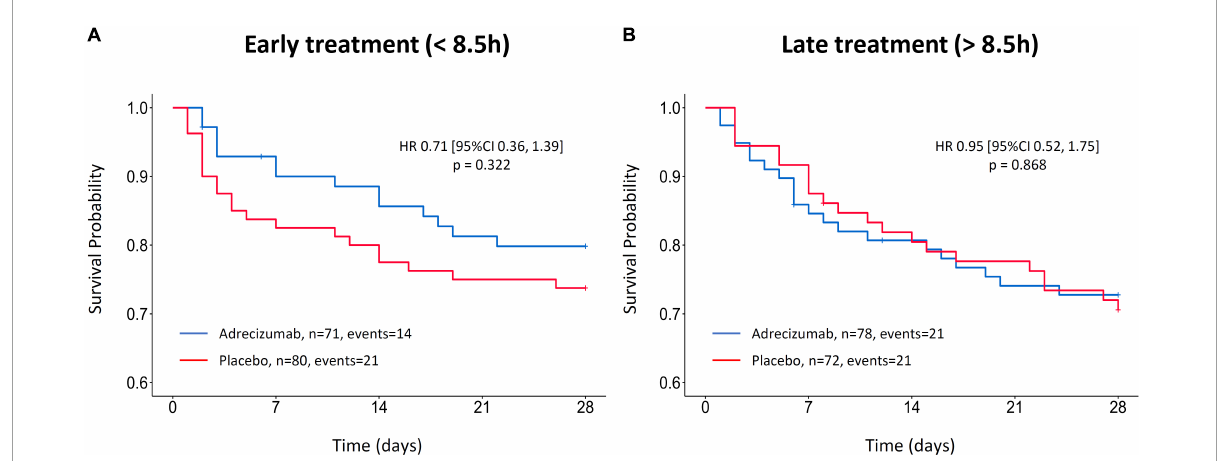
FIGURE3 Kaplan–Meier of 28-day mortality after Adrecizumab/placebo infusion, based on treatment timing stratification. (A) Kaplan–Meier of patients treated < 8.5 h after septic shock diagnoses. (B) Kaplan–Meier of patients treated > 8.5 h after septic shock diagnosis. Both Adrecizumab dosing groups were combined. Crosses represent censored